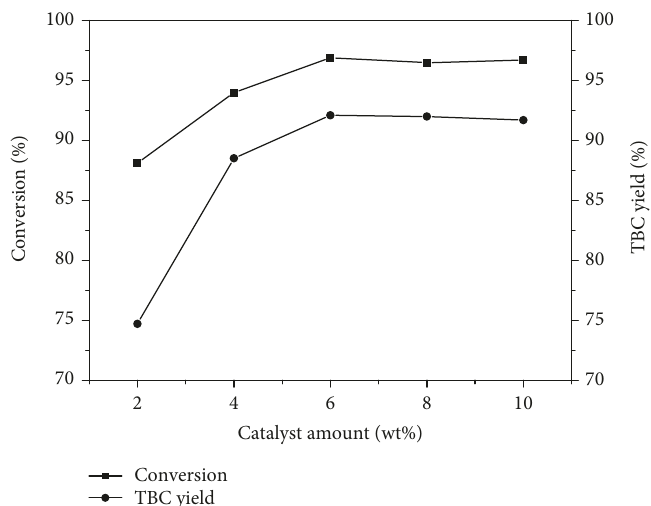
Figure 2: E ff ect of the catalyst amount on the esteri fi cation of citric acid with n-butanol. Reaction conditions: citric acid, 0.06mol; n-butanol, 0.3mol; temperature, 115 ° C; time, 5